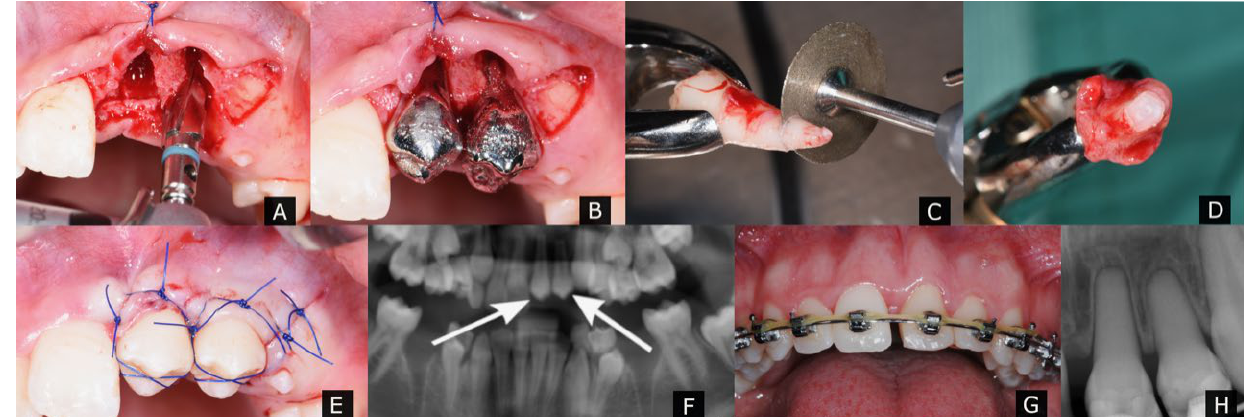
Figure 2. Autotransplantation of two mature premolars to the anterior left maxilla. ( A ) Recipient site preparation. ( B ) Tooth replica. ( C ) Root-end resection. ( D ) Enlarged diameter of the apical foramen. ( E ) Postoperative clinical image. ( F ) Postoperative radiograph image with arrows ranging from the donor to the recipient regions. ( G ) 4-year follow-up. ( H ) Intraoral radiograph 4 years after surgery with pulp obliteration.